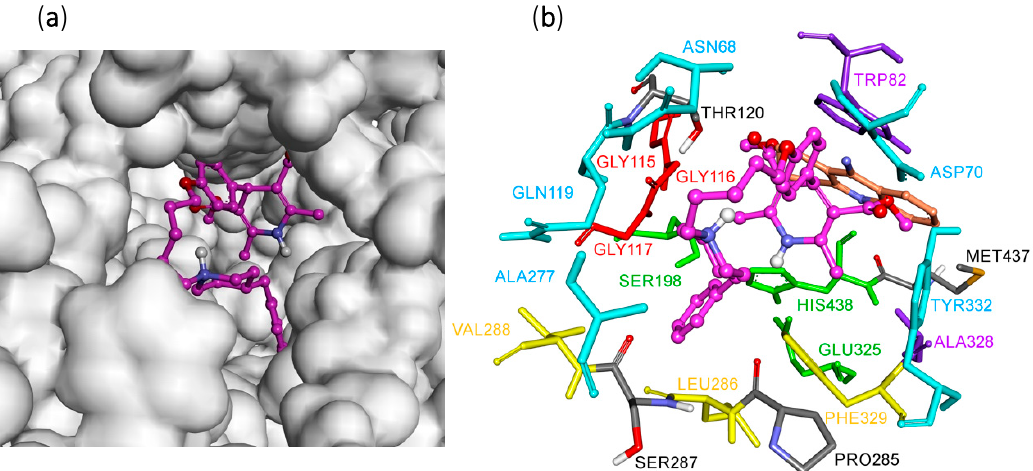
Figure 3. Docking pose of compound 3h and tacrine inside gorge cavity of hBuChE. ( a ) Top view of the accessible surface of the active site gorge (white), compound 3h is rendered in pink ball and stick model. ( b ) Compound 3h was shown in pink, tacrine in brown, catalytic anionic site (CAS) in green, OH in red, choline binding site (CBS) in violet, ABP in yellow, and PAS in blue.